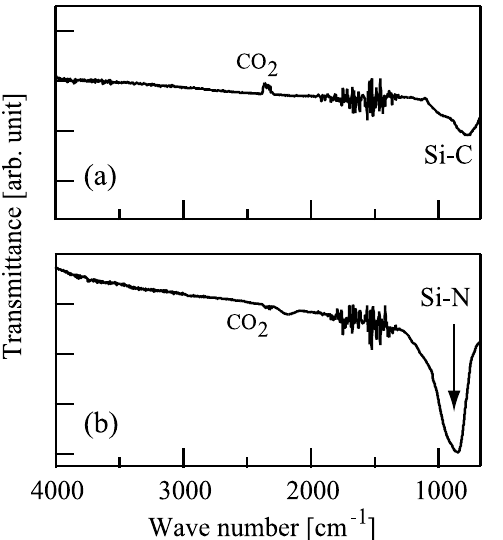
Fig 6. The Fourier-transform infrared spectra of films deposited on Si substrates following the injection of (a) Ar + and (b) N + ions in conjunction with hexamethyldisilazane. Substrate temperature during the deposition experiments was 540 ˚C. The duration of the deposition experiments was 28